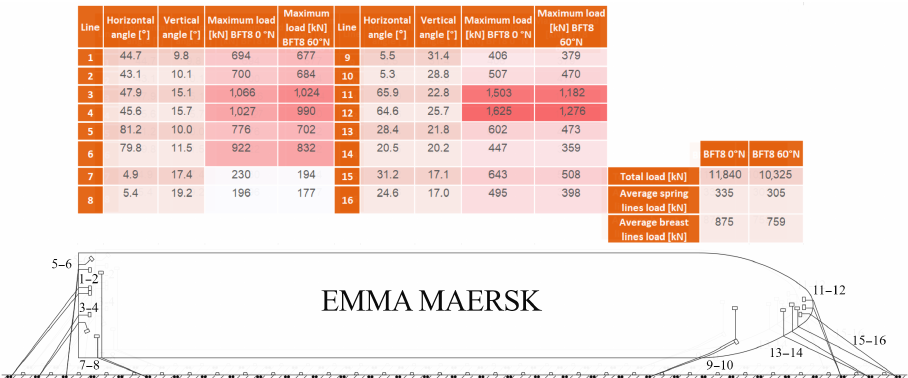
Figure 12. Maximum line loads and angle distribution in the Emma Maersk.